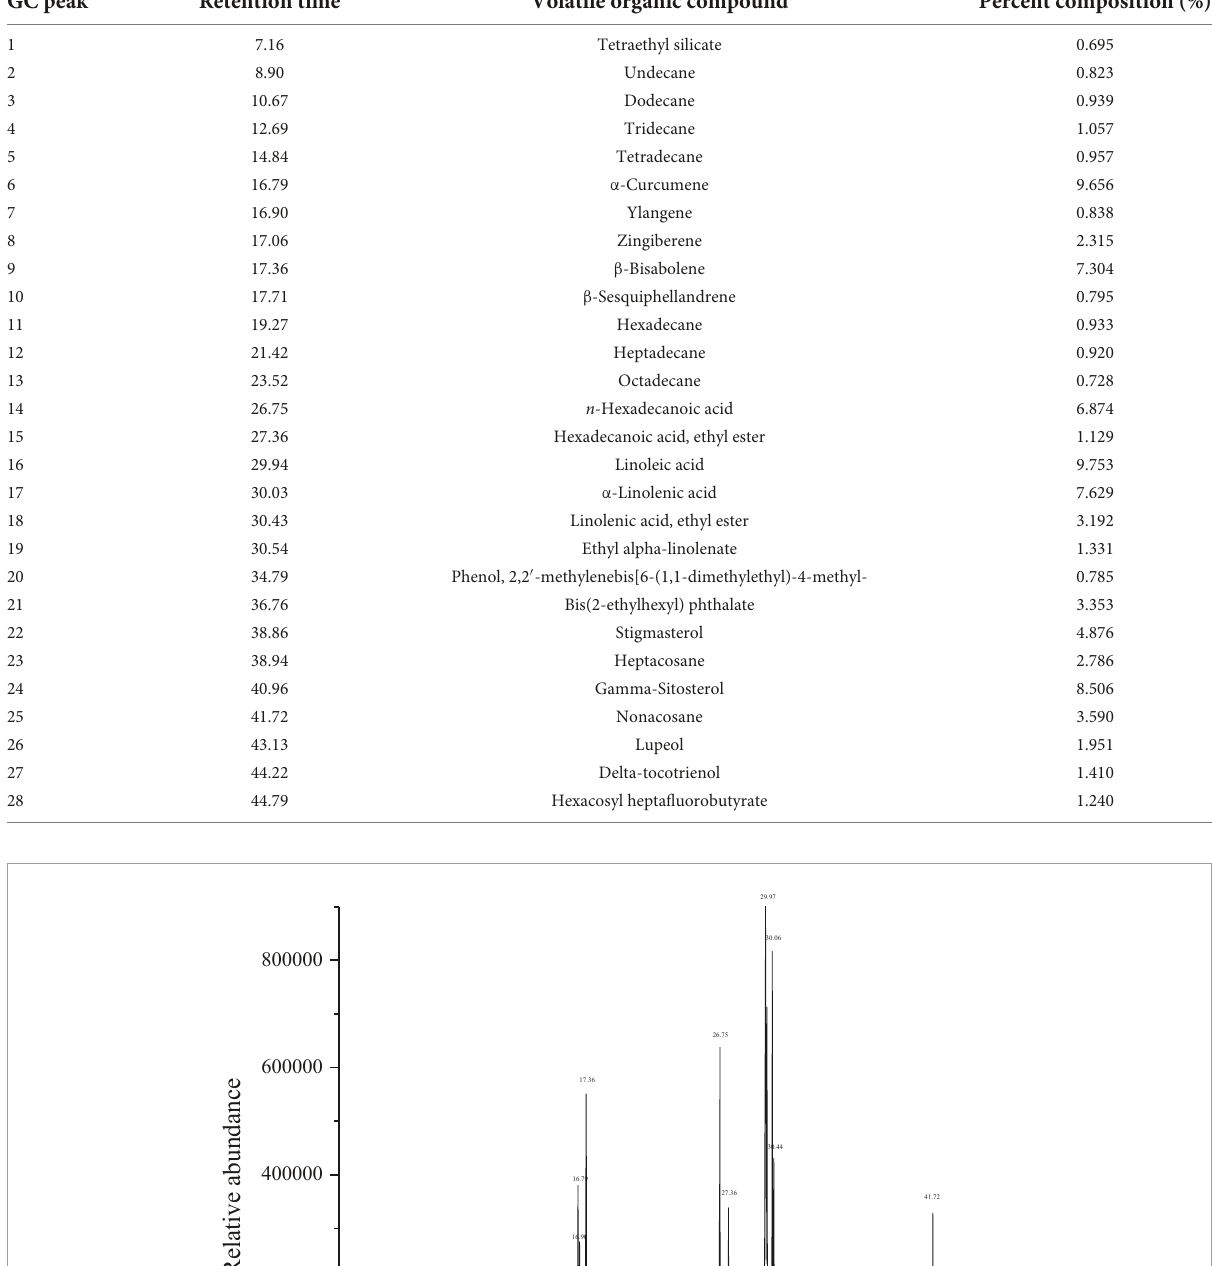
TABLE 1 Chemical compositions of volatile compounds of litchi flower essential oil (LFEO).